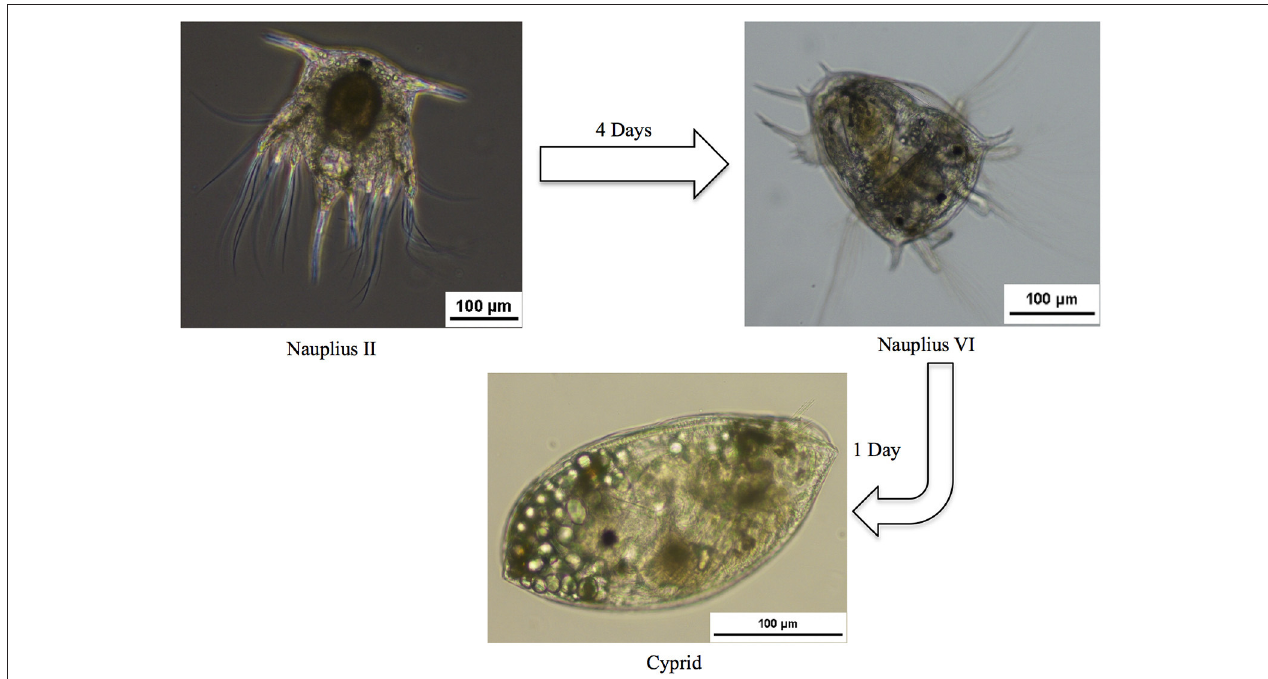
FIGURE 1 | Developmental stages of B. Amphitrite